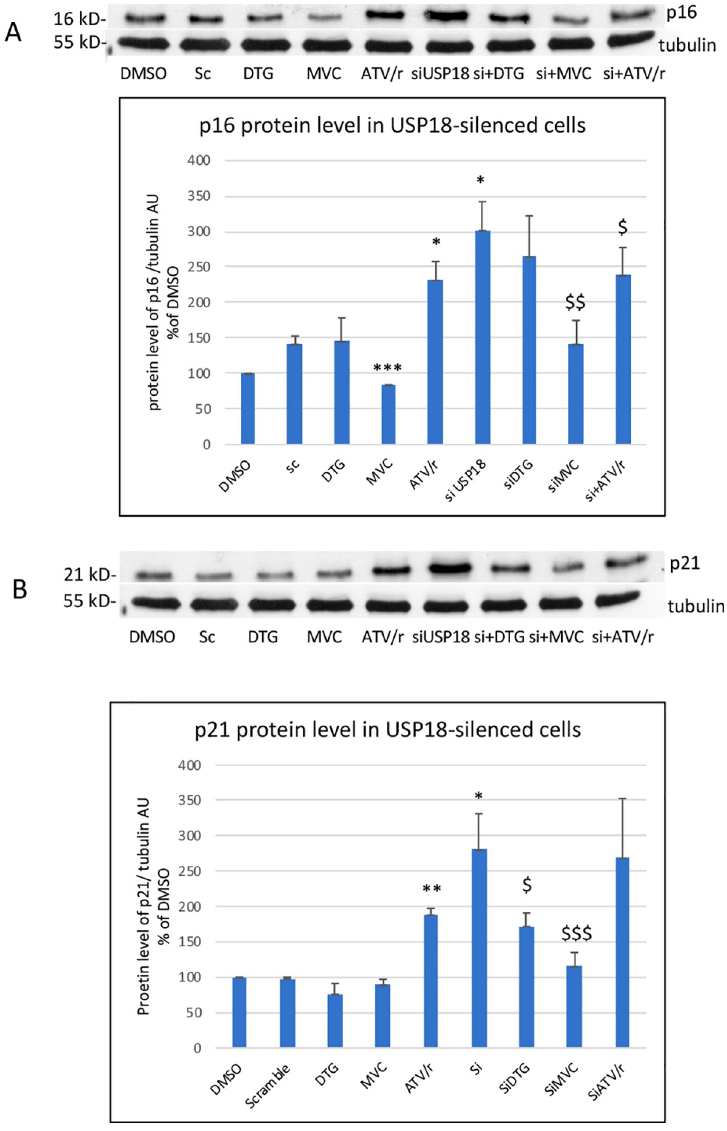
Fig 8. Effect of USP18 silencing on the ability of DTG, MVC and ATV/r to modulate the protein level of p16 and p21. Representative Western blots are shown of p16 and tubulin as a loading control in A and of p21 and tubulin in B. The histograms represent the mean+/-SEM value as compared to the DMSO control set at 100% of 3 independent experiments. Si-DMSO: control silenced for USP18, Si-DTG: DTG-treated cells silenced for USP18, Si-MVC: MVC- treated cells silenced for USP18, Si-ATV/r: ATV/r-treated cells silenced for USP18. The comparisons used Welch’s correction of Student T-test. � p < 0.05, ��� p < 0.001 versus control (DMSO) $ p < 0.05, $ $ p < 0.01 versus Si-USP18 (Si-